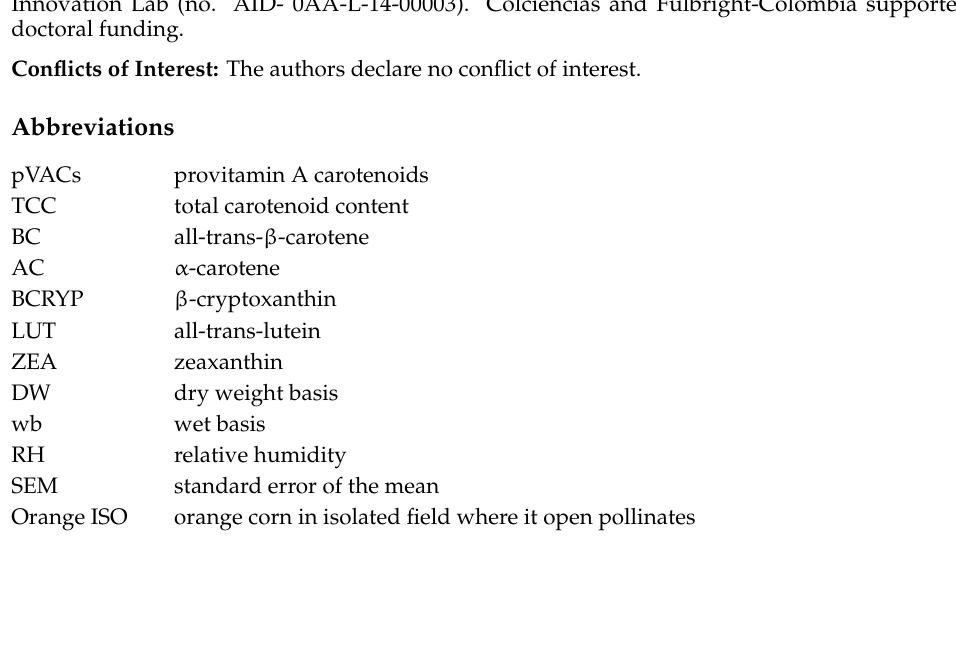
Table S1: pH of the slurry water after the steeping period; Table S2: Carotenoid retention during wet cooking (% of starting